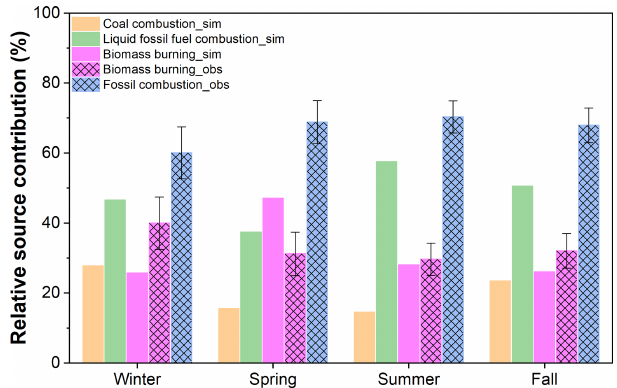
Figure 11. Comparison of seasonal source contribution to BC be- tween the source-oriented model and the aethalometer